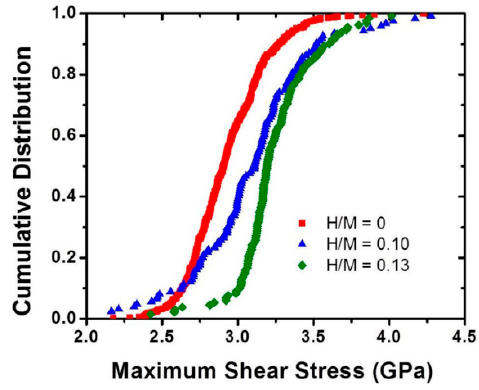
Figure 3. Cumulative distribution of the first pop-ins against the maximum shear stress of samples with di ff erent c H .